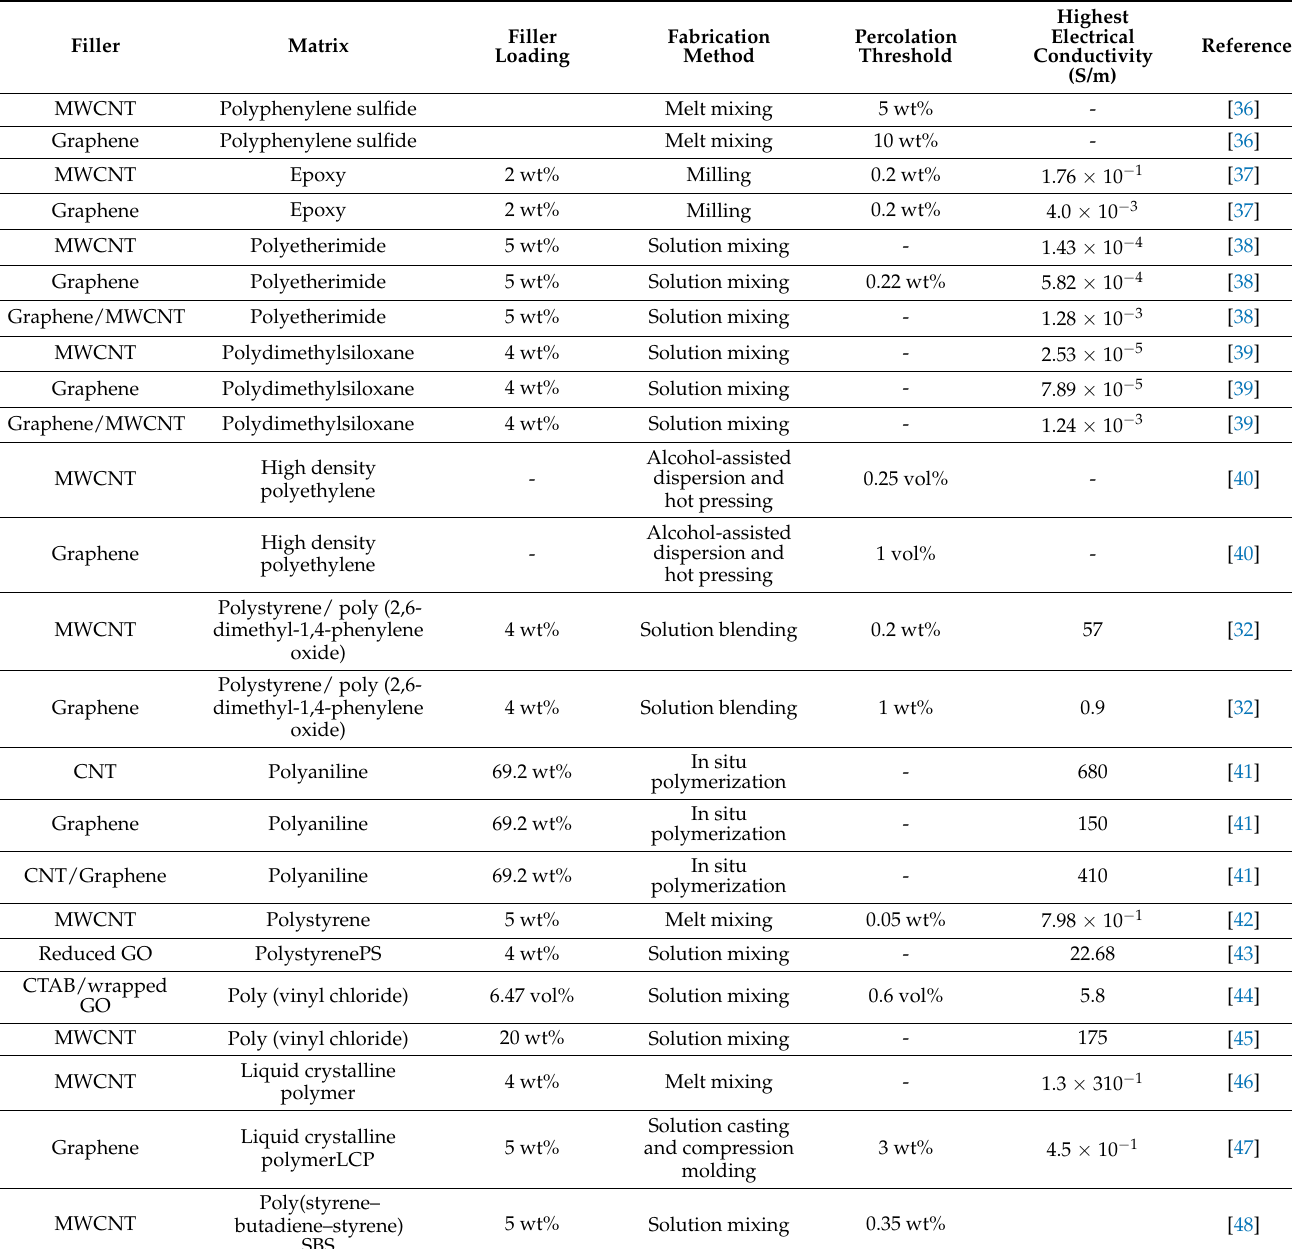
Table 3. The electrical conductivity and percolation threshold of carbon nanotube/graphene-based polymer nanocomposites.